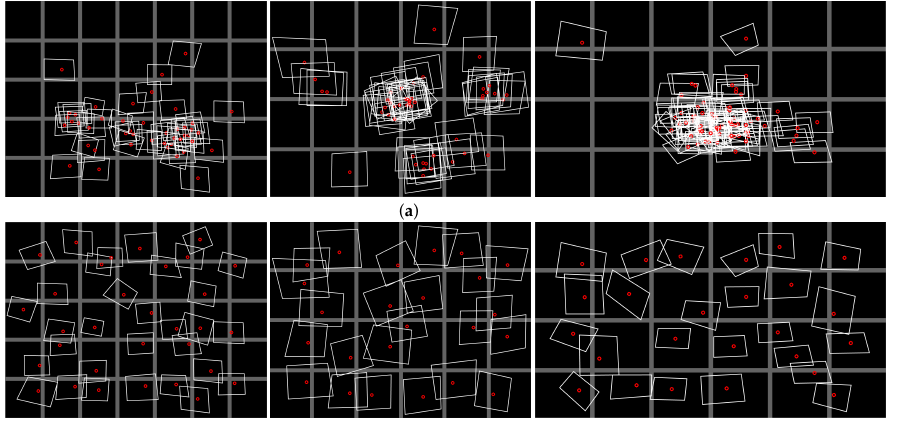
Figure 9. Six examples of localization of the fingerprints (white frames) of the patterns detected in a set of calibration data on the grid of the sensor zones (gray grid): ( a ) not guided blind acquisition, ( b ) guided blind acquisition with